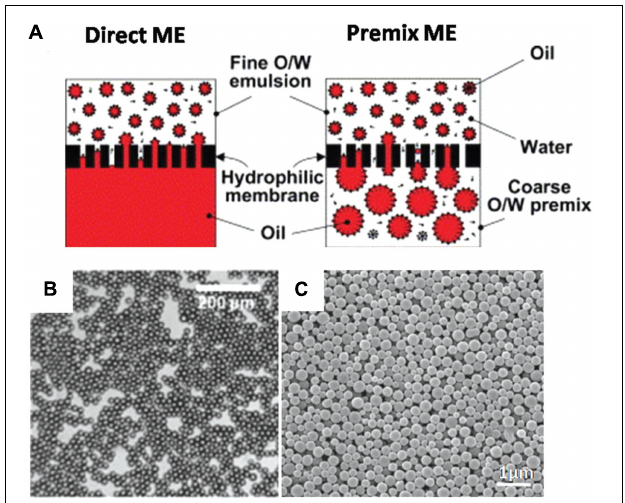
FIGURE 9 | (A) Direct- and premix- two common processes using membrane extrusion (ME). (B) SEM image of an emulsion formed by this method (C) SEM images of nanoparticles formed by premix ME, reproduced from Guo et al. (2018).